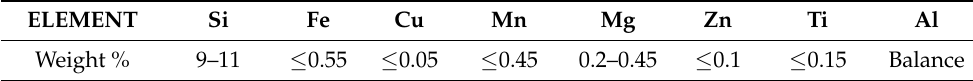
Table 1. Composition of AlSi10Mg alloy powder as per DIN EN